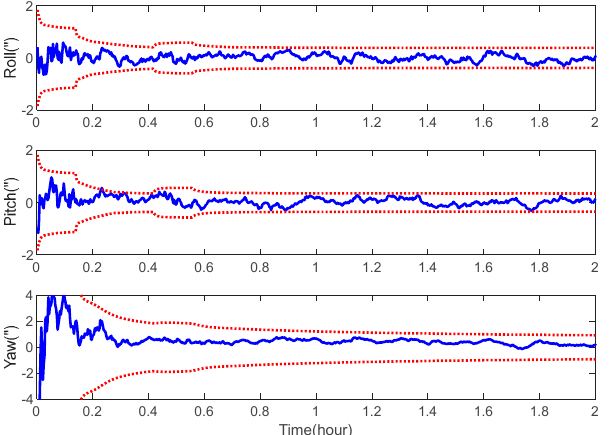
Figure 16. Attitude error of space-target-based INS/Vision integrated navigation. As expected, the position, velocity and attitude can all be estimated correctly by the measurement of the LOS vectors of the space targets and starlight vectors. The mean esti- mation errors of the position, velocity and attitude of the space-target-based INS/Vision integration were 12.96 m, 0.32 m/s and 0.94 ″ , respectively. This shows that the presented method has the potential to realize the absolute navigation of unmanned aircrafts with a high accuracy. For the implementation of the navigation method, the position error of the